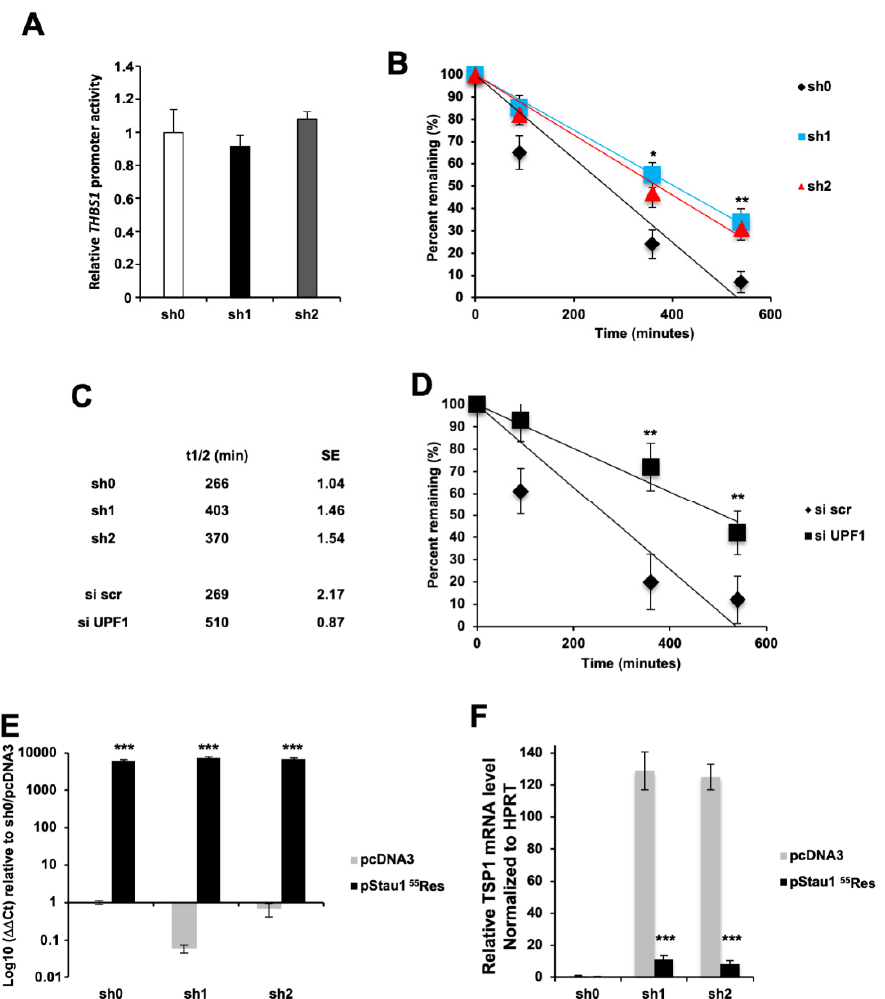
Figure 8. THBS1 is degraded by Staufen1 mRNA decay. ( A ) THBS1 promoter activity is not affected by Stau1-KD in H460 cells. ( B , C ) THBS1 transcript half-life is increased by Stau1 knock-down. ( D ) THBS1 transcript half-life is increased by UPF1 knock-down. ( E ) Stau1 expression is rescued in sh1 and sh2 H460 cell lines by a plasmid encoding a Stau1 mRNA resistant to sh1 and sh2 mRNA degradation (pStau1 55 Res) when compared to empty vector (pcDNA3). ( F ) THBS1 mRNA levels are strongly reduced when Stau1 is re-expressed in sh1 and sh2 cells. (Asterisks: * p < 0.05; ** p < 0.01 and *** p < 0.001 in two-tailed Student’s t-test).